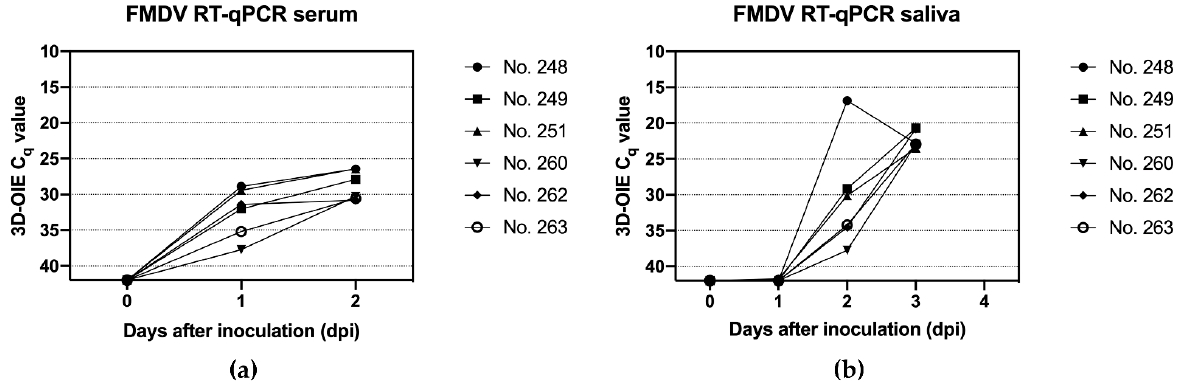
Figure 3. FMDV RT-q-PCR results after injection of naked FMDV RNA in the first animal trial: ( a ) saliva samples; ( b ) serum samples. See Table S3 in the Supplemental Material for the raw data summarized in this figure.